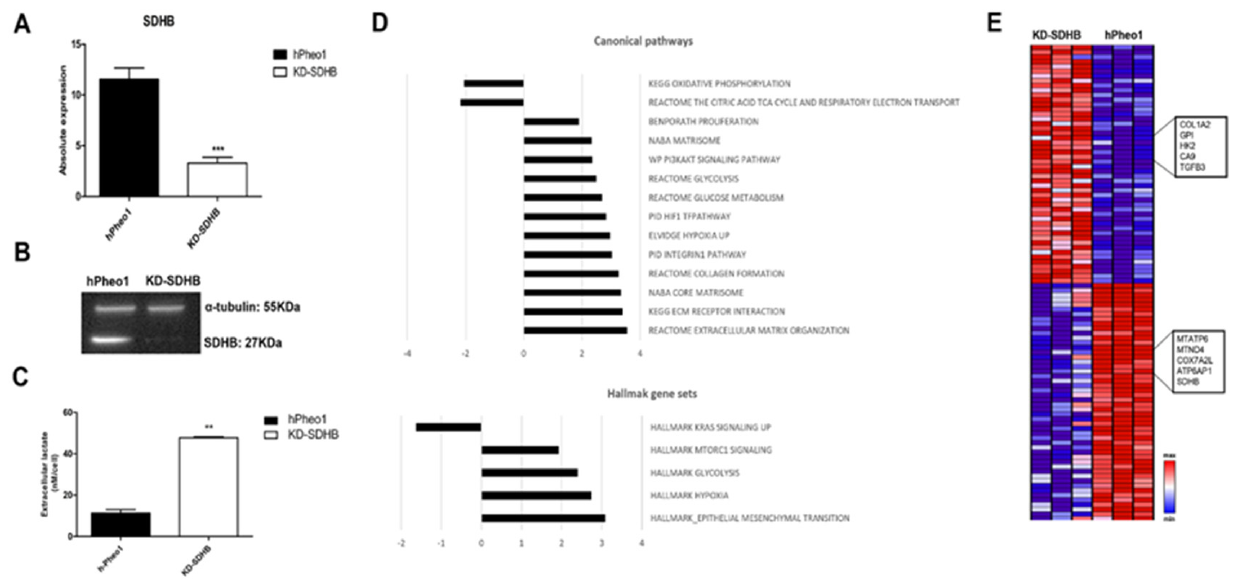
Figure 1. Effects of knockdown SDHB on hPheo1 cell line. ( A ) mRNA expression in control (black bar) and KD-SDHB (white bar) hPheo1 cells is presented as absolute quantification with ddPCR; each bar represents the mean ± standard deviation of three independent experiments, *** ( p < 0.0001), student’s t -test. ( B ) Protein expression in hPheo1 (control) and KD-SDHB analyzed with Western blot using antibodies against SDHB and Alpha-tubulin. ( C ) Lactate concentrations in the medium were measured in KD-SDHB cells and hPheo1 control cells. p value calculated with student’s t -test indicated as ** ( p < 0.001). ( D ) Top-ranked gene sets in the Canonical Pathways and Hallmark sets (up/down regulated). ( E ) Hierarchical clustering of hPheo1 and KD-SDHB cell lines based in mRNA expression levels. The normalized expression 2-log is displayed with z scores and altered expressed genes belong to glycolysis, hypoxia, cell proliferation, cell differentiation, and oxidative phosphorylation gene pathways.